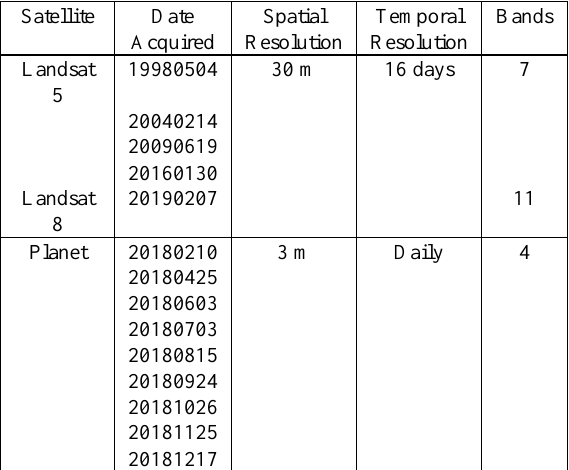
Table 1. Satellite imagery details collected from 1998 to 2019